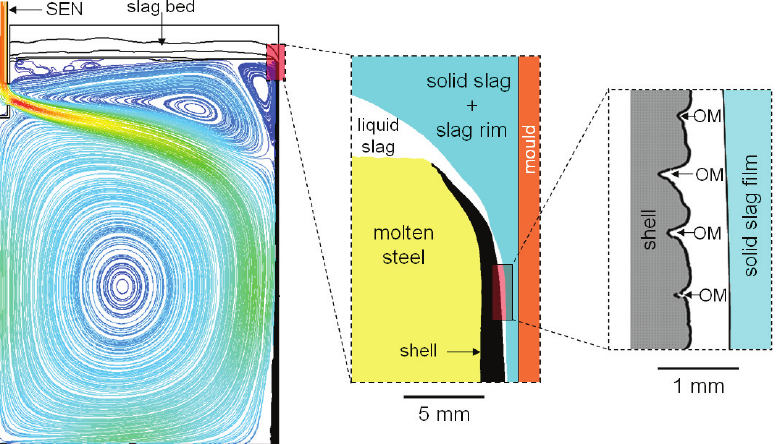
Figure 2. Model predictions showing flows, shell, solid and liquid slag films, standing waves and formation of oscillation marks